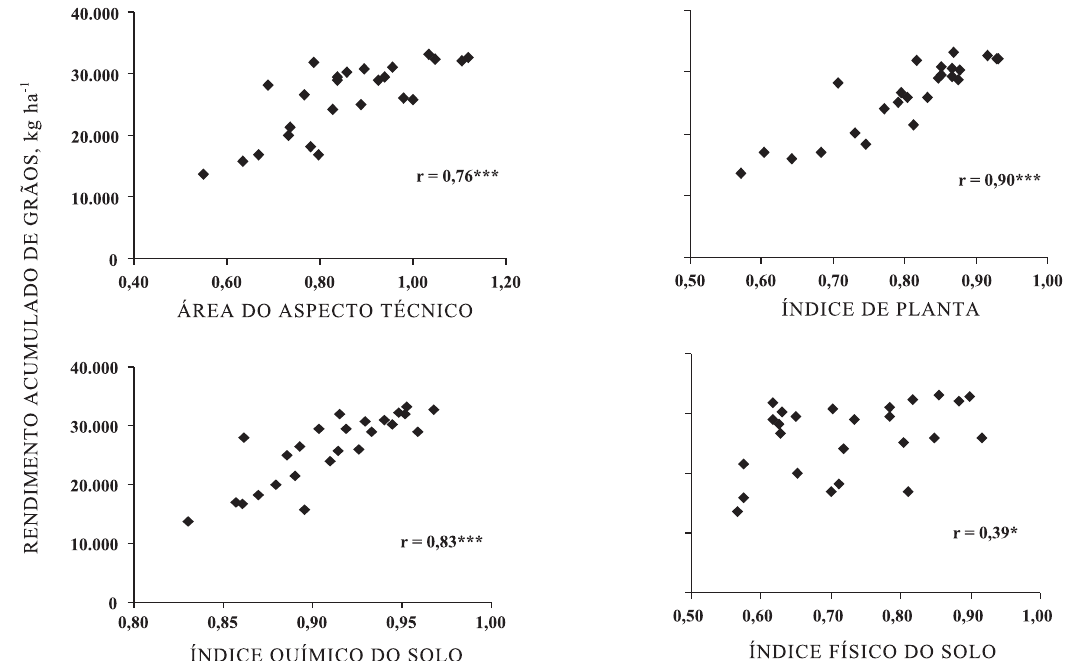
Figura 3. Rendimento acumulado de grãos das culturas comerciais durante nove anos, em função da área do aspecto técnico, do índice de planta, do índice químico e do índice físico do solo (* p = 0,05; *** p =